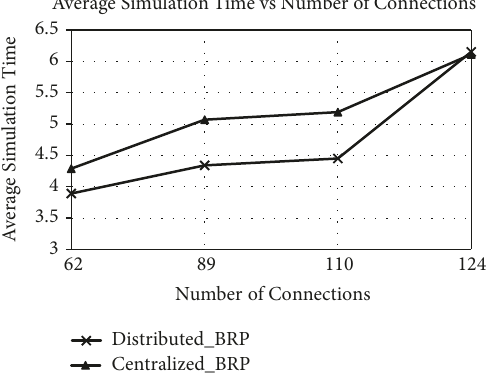
Figure 16: Average connection established time vs number of connections in Germany topology.